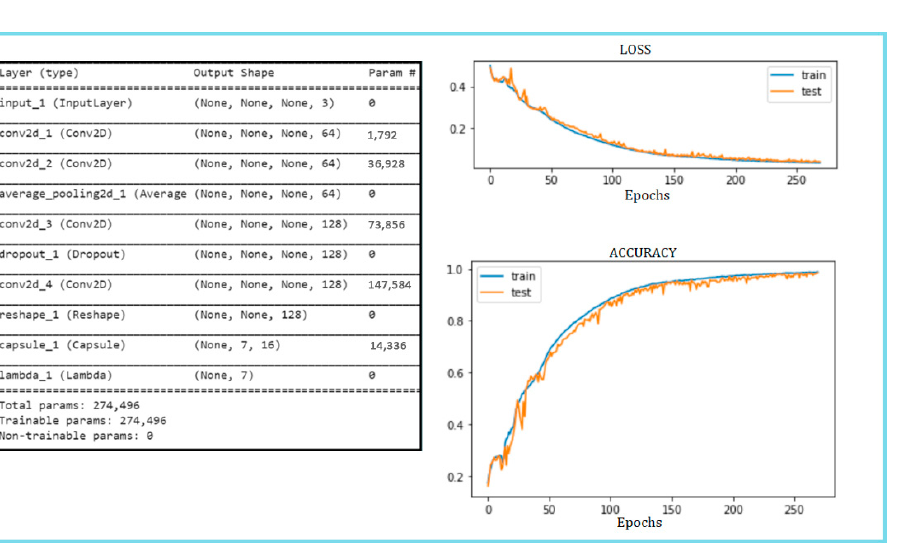
Figure 7. Model Structure, loss-accuracy graphs.